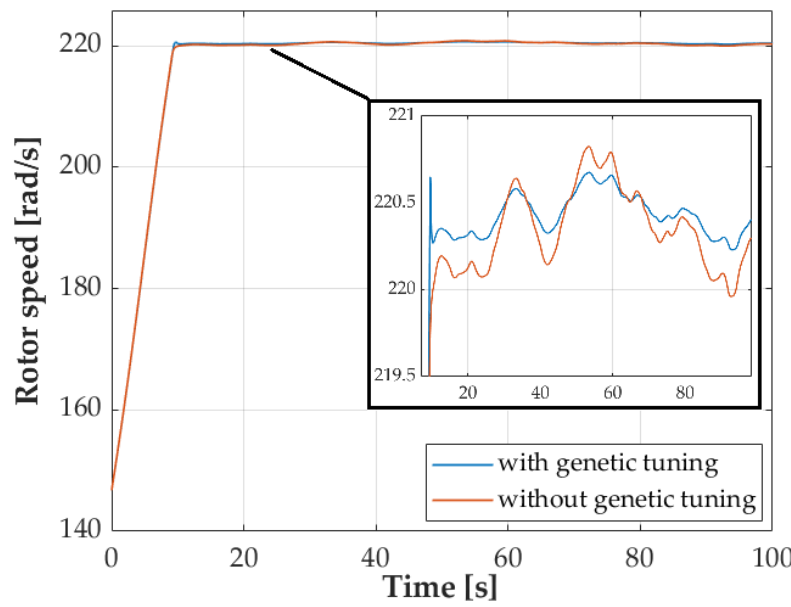
Figure 13. Rotor speed with (blue line) and without (red line) using genetic algorithm.